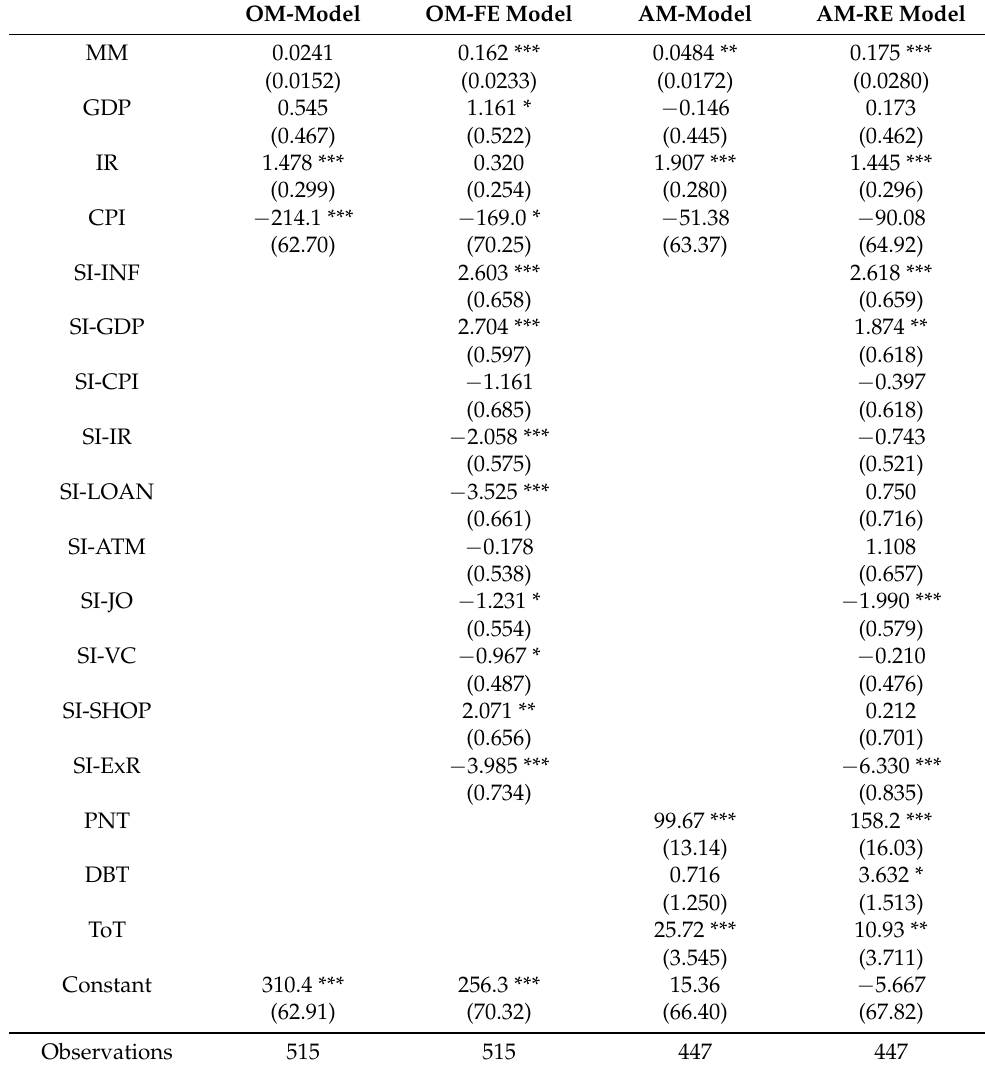
Table A9. Panel Regression OM-Fixed-Effects and AM-Random-Effects Models 1.